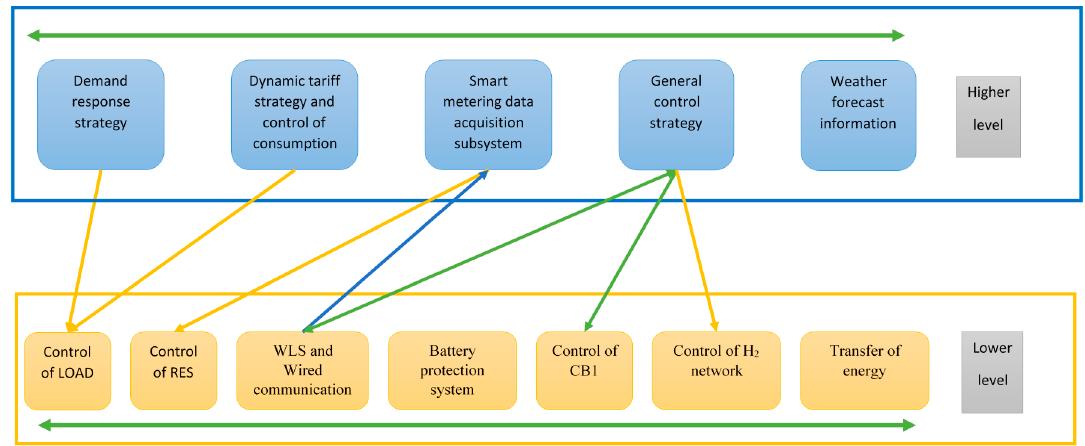
Figure 8. The structure of the SEM control and the control levels.